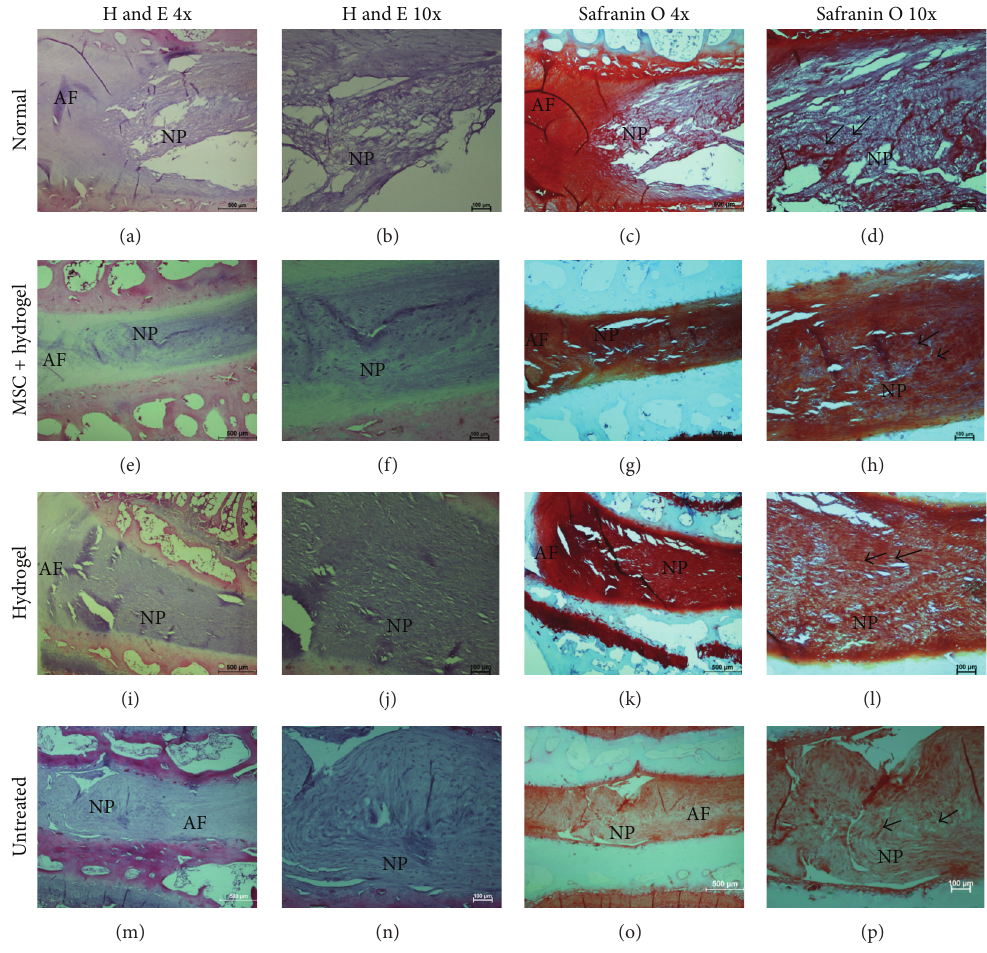
Figure 8: Typical histological changes in normal disc (a–d), MSC and hydrogel (e–h), hydrogel (i–l), and untreated (m–p). On Safranin O stained sections, a moderate-to-severe degeneration was observed in the hydrogel (k, l) and untreated (o, p) groups with formation of fibrocyte-like cells. In the MSC containing hydrogel group, the increasing number of chondrocyte-like cells which appeared as large cells encircled with pericellular matrix densely stained with Safranin O was found in the nucleus pulposus (g, h).